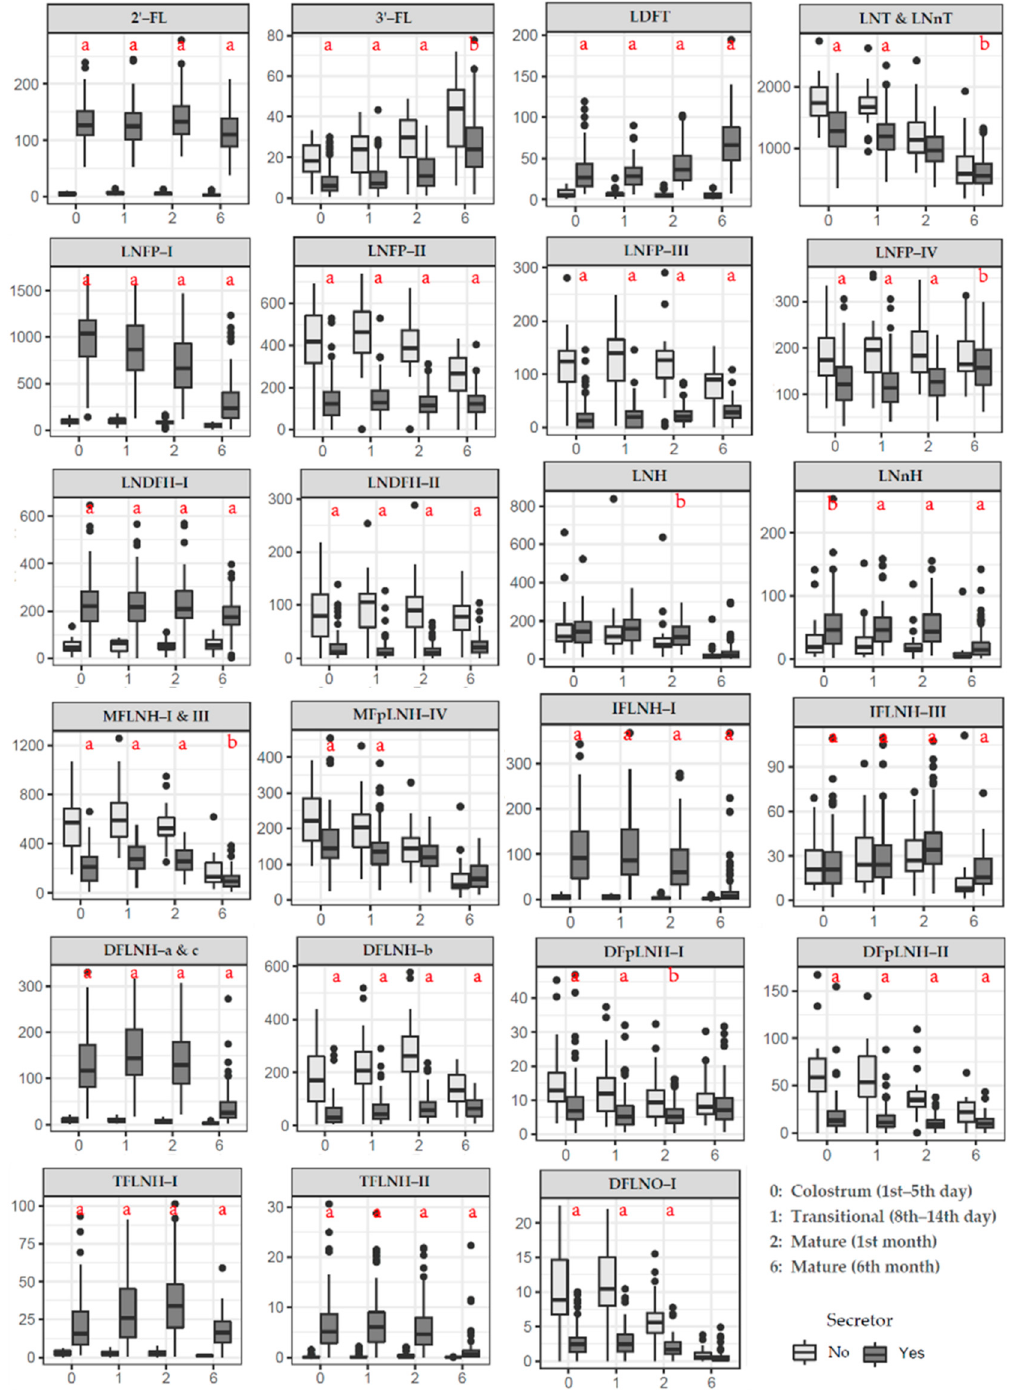
Figure 2. Mean concentration of HMOs during different lactation periods for secretors and non- mg / L. Letters indicate if di ff erence between Secretors and Non-Secretors is significant; a: p < 0.001, secretors, mg/L. Letters indicate if difference between Secretors and Non-Secretors is significant; a: p b: p < < 0.001, b: p < 0.05.